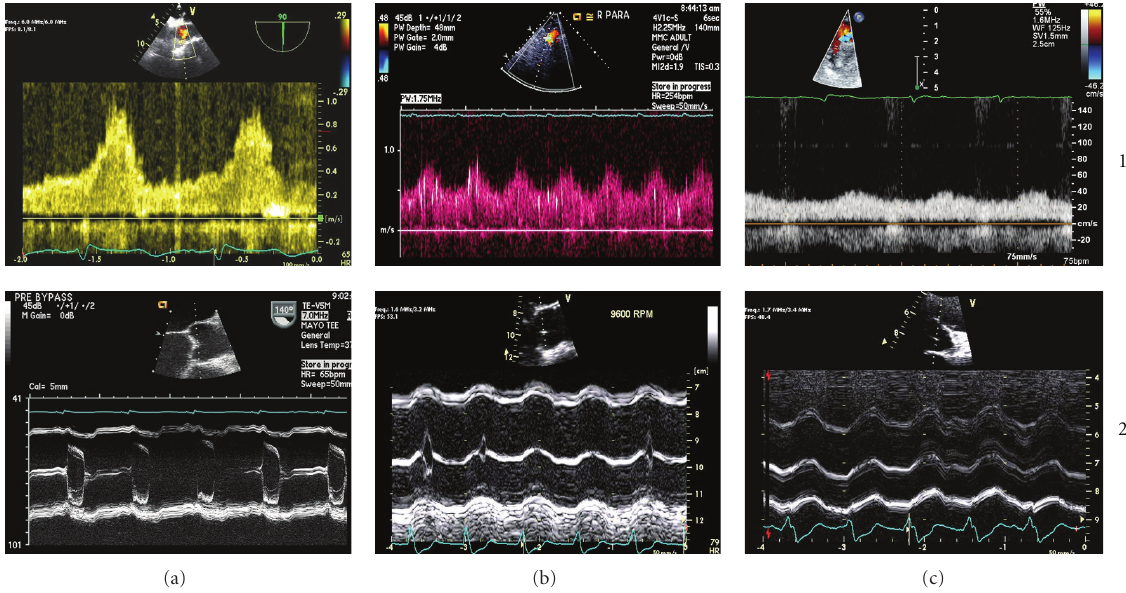
Figure 5: LVAD speed settings. Columns: (a) minimal speed; (b) submaximal speed; (c) maximal speed. Rows: (1) pulsed Doppler, outflow cannula; (2) M mode aortic valve. The status of aortic valve opening and aortic flow pulsatility depends on pump speed and output, LV contractility, preload, and afterload conditions. Reduction in LVAD speed to minimum will result in minimal unloading of the LV, increased LV systolic pressure above aortic pressure allowing pulsatile flow (a1), aortic valve opening during every cycle, seen in M mode (a2). Increasing the speed to submaximal, will unload the ventricle, reduce systolic left ventricular pressure, decrease the outflow pulsatility (b1), and result in intermittent aortic valve opening in M mode (b2). Increasing speed to maximum will unload the left ventricle even further, resulting in almost continuous aortic flow (c1), and no aortic valve opening